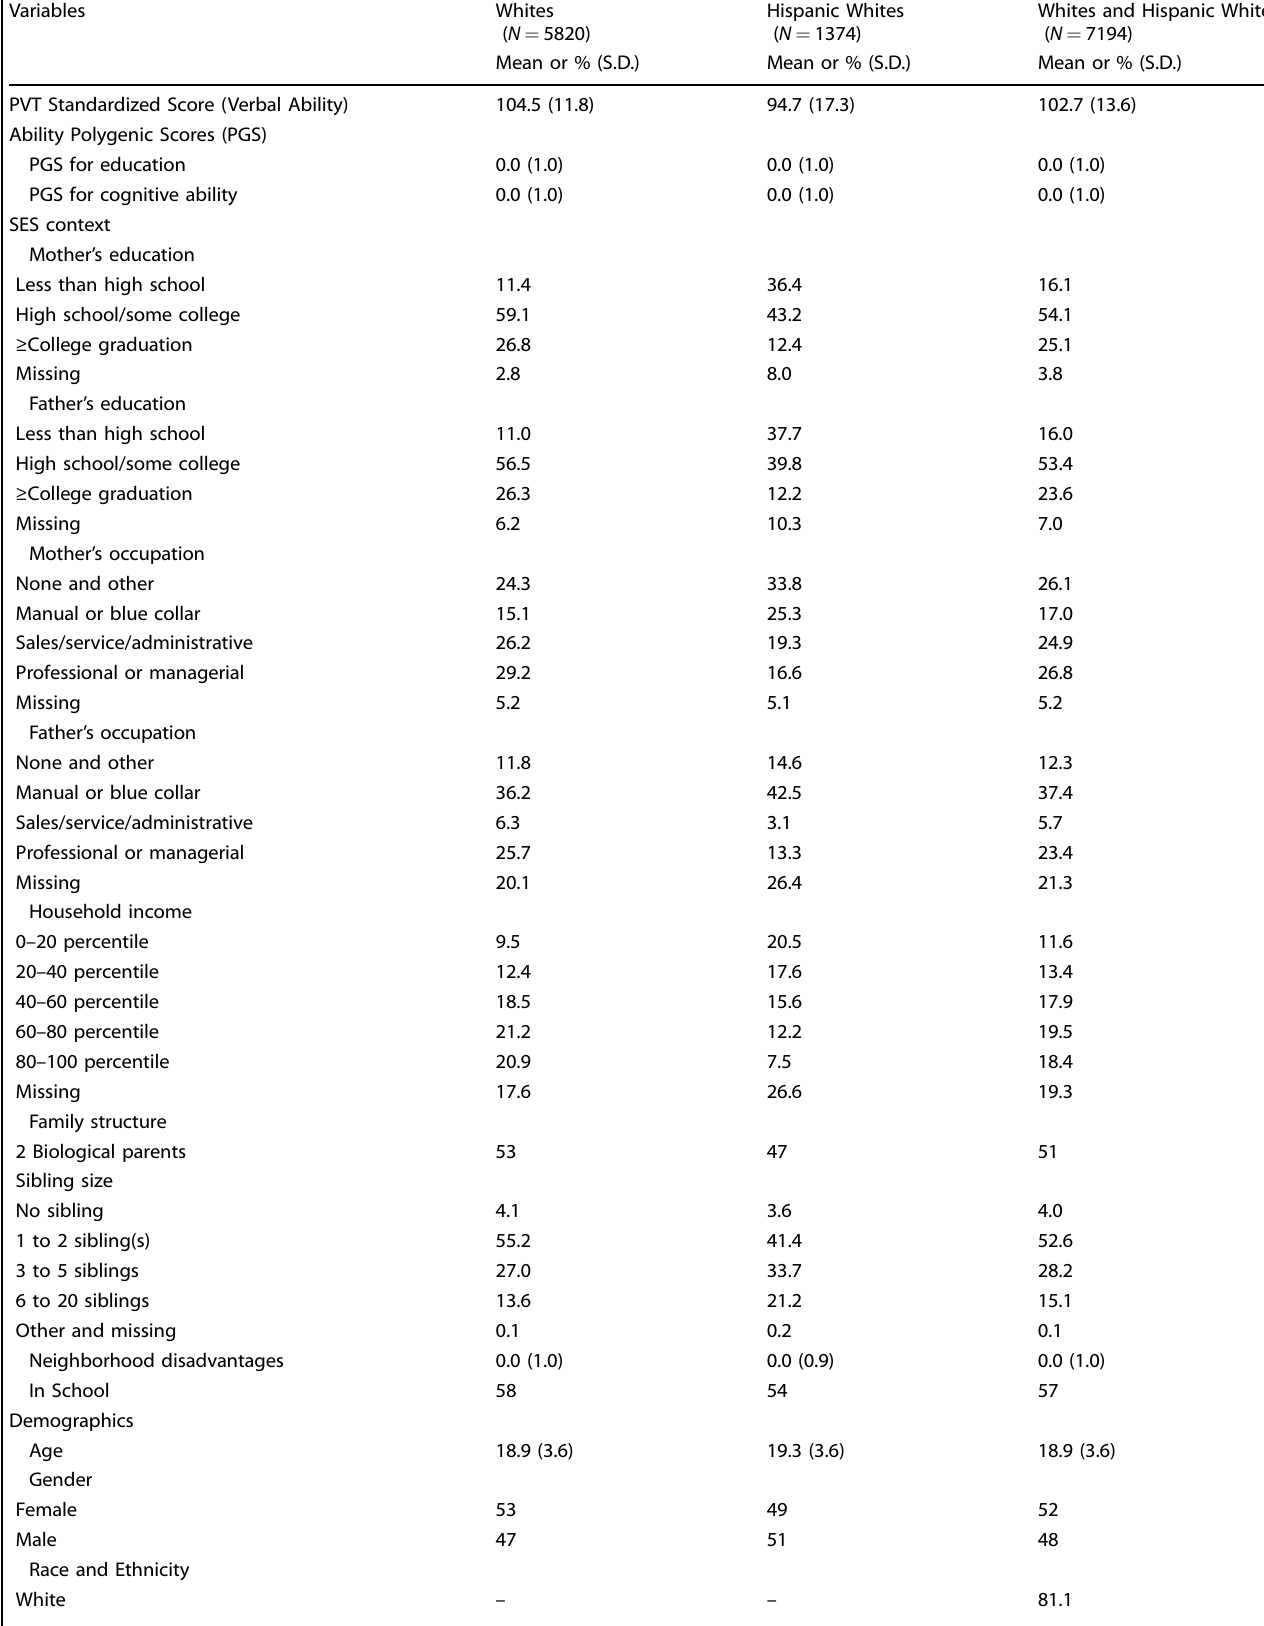
Table 1. Descriptive statistics for the Add-Health